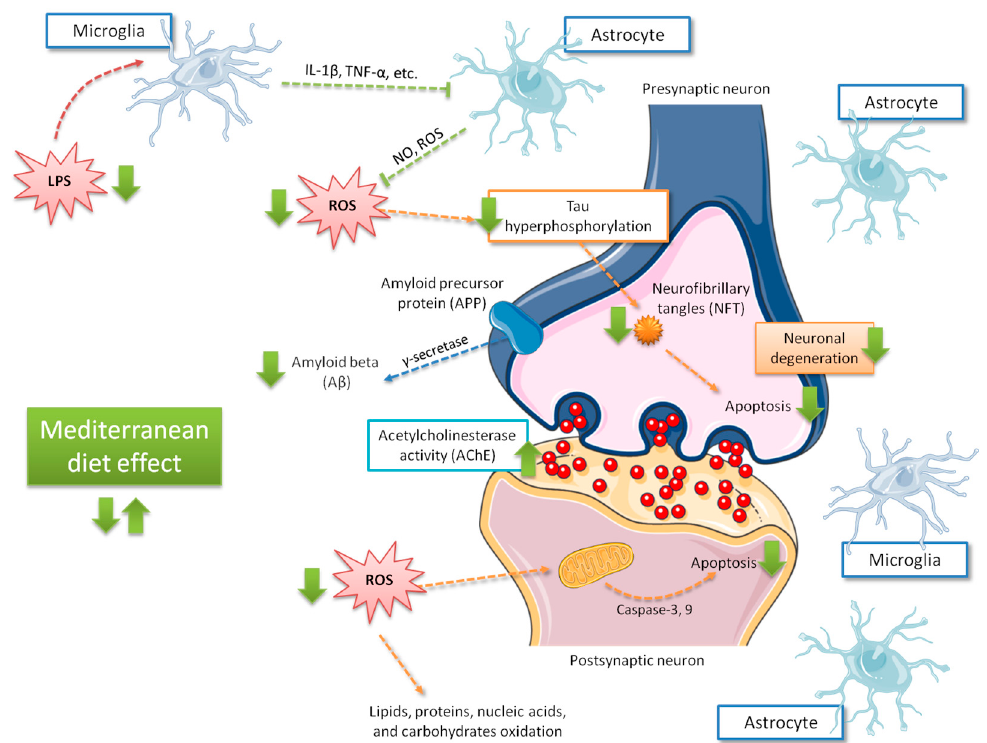
Figure 3. Main e ff ects related to Mediterranean diet adherence on cognitive function. Green arrows indicate the increase of the possible e ff ects on brain, those including ROS production decrease and, in consequence, less tau phosphorylation, apoptosis, A β accumulation, and neurodegeneration. IL-1 β , interleukin 1-beta; LPS, lipopolysaccharide; NO, nitric oxide; ROS, reactive oxygen species; TNF α , tumor necrosis factor alpha.